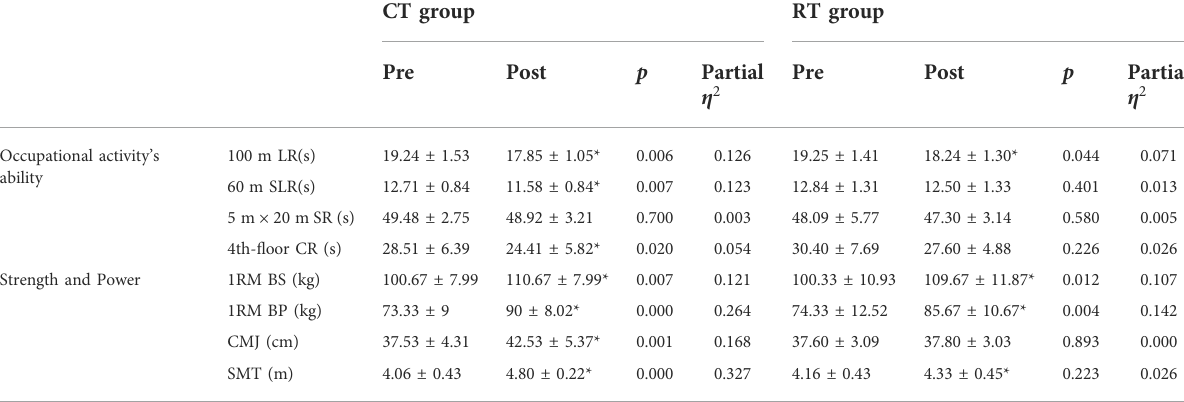
TABLE 1 Descriptive statistics of results for CT and RT group before and after the 12-week training